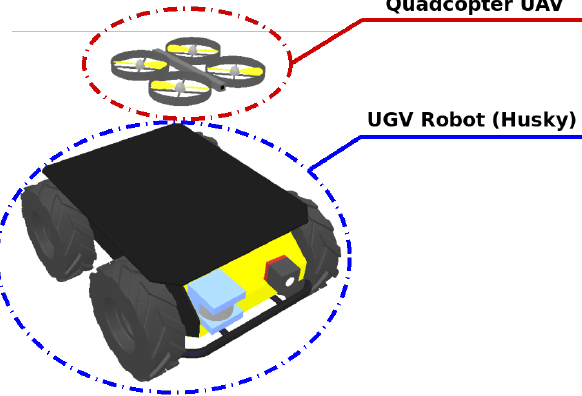
Figure 16. UGV model used in this